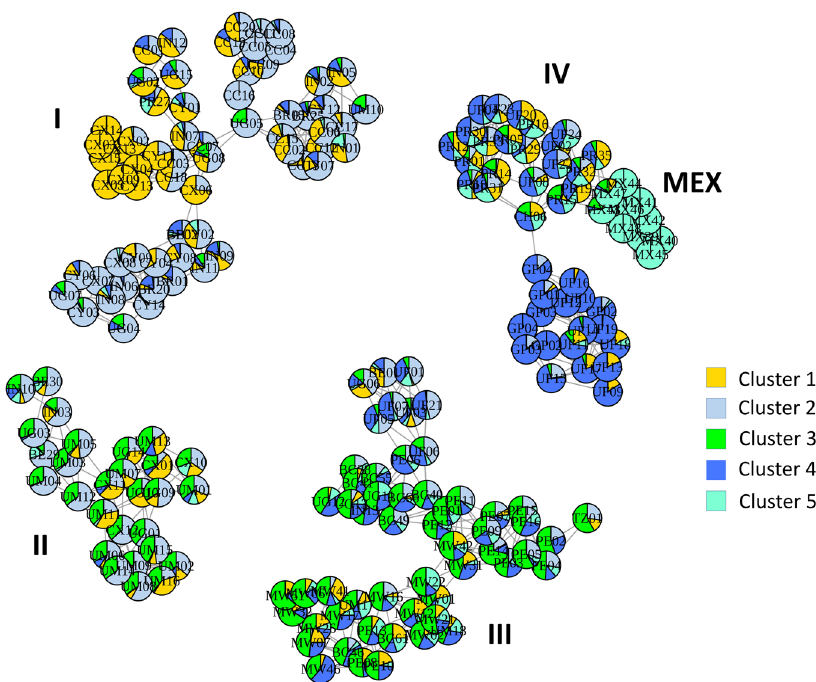
Fig. 6 Maximum Likelihood distance network with admixture analysis of invasive and native Spodoptera frugiperda populations. Maximum likelihood (ML) distance network with admixture analysis inferred from fi ve genetic clusters ( K = 5) presented as pie charts for each individual analysed. The network was drawn using the plotAdmixture function in the R package NetView 120, 121 , and is based on a ML distance matrix calculated from the IQ-Tree shown in Fig. 3. using the R package ape 122 . The four major clusters, I – IV, correspond to those shown in the phylogenetic tree (Fig. 3). Individuals are identi fi ed by country codes as follows: China XP (CX), China YJ (CY), China CY (CC), China CH06 (CH), India (IN), Uganda (UG), Tanzania (TZ), Malawi (MW), Benin (BE), Brazil CC (BC), Brazil rCC (BR), Peru (PE), French Guiana (GF), Mexico (MX), Guadeloupe (GP), Puerto Rico (PR), USA-Florida (UF), and USA- Mississippi (UM). See Supplementary Data 1 for complete information about the individuals. Cluster I comprises predominantly different Chinese populations each with distinct admixture pro fi les but included also genetic cluster pro fi les of individuals from Uganda, India, Brazil-rCC (BR) and Puerto Rico. In cluster II, China-XP (CX), India, Benin, and Uganda formed networks with USA-Mississippi individuals. In Cluster III, all Malawi individuals and various Tanzania and Uganda individuals were grouped with Peru, Brazil-CC (BC), and selected USA-FL individuals. In cluster IV, only one Chinese FAW (CH) was found to a group to this predominantly Caribbean/Central America FAW group (consisting of USA-FL, Puerto Rico, French Guiana, Guadeloupe, and Mexico FAW individuals). Note that individuals sharing the same colour schemes do not necessarily have the same genetic content, and that the MEX group consisted only of individuals from Mexico showing little admixture with any other